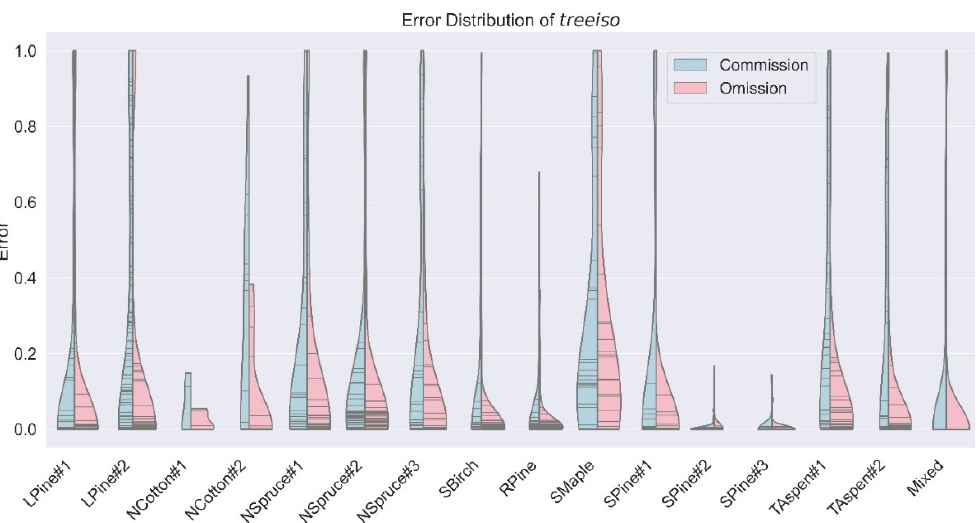
Figure 10. Plot-level summaries of the commission and omission error distributions for individual trees. The commission and omission error were placed side by side for each of the sixteen plots to provide visual contrast. Within each violin, each tree has one commission (one solid horizontal line in the light blue half) and one omission error (one solid horizontal line in the light pink half). A violin creates a smooth outline to illustrate the distribution of plot-level error frequencies. The width of one horizontal line denotes the relative frequency of the error where the total area of a violin is normalized to